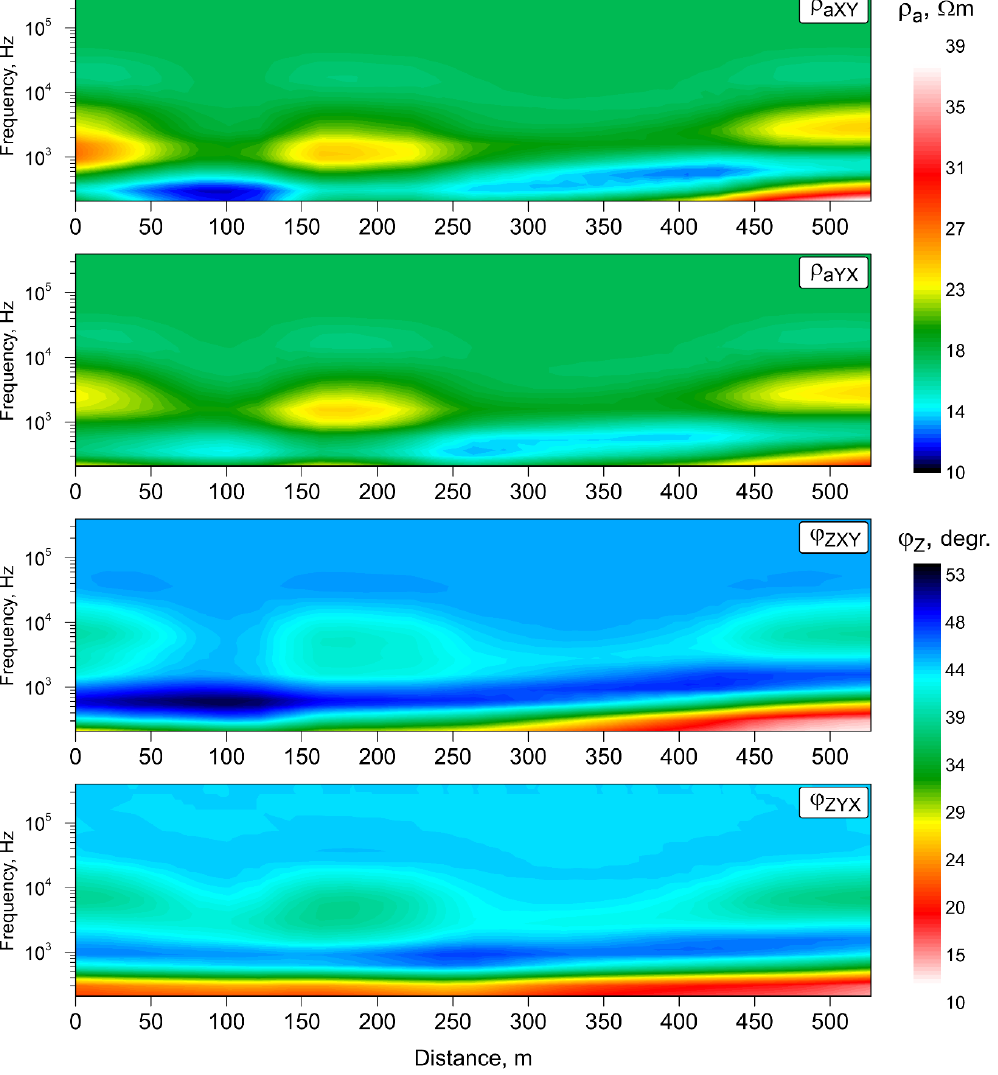
Figure 11. Results of the numerical simulation. Pseudo cross-sections along receiver line No. 6. Top two panels: XY and YX apparent resistivity. Bottom two panels: Impedance phase components, XY and YX.